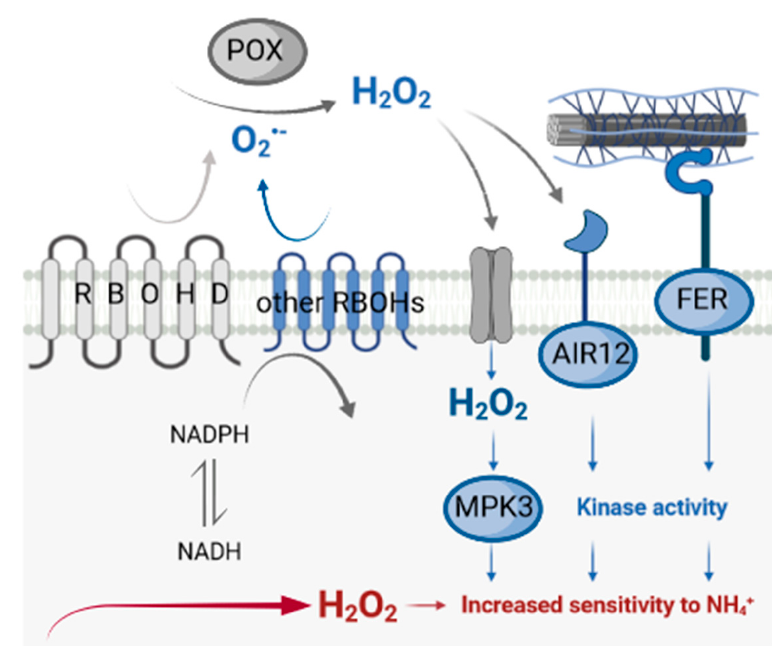
Figure 7. Metabolic effects of RBOHD disfunction for plants nourished with ammonium. When the major RBOHD is not active, other RBOHD isoforms cannot compensate for its activity, and O 2 − production is diminished. Lower O 2 − availability or POX activity can lead to decreased H 2 O 2 contents as their product. As a consequence, H 2 O 2 -responsive receptors such as AIR12 are downregulated. Another cell-wall receptor is FER, and decreased pectin methyl-esterification leads to lower expression. Further signaling pathways from these receptors are not activated in cells, such as in the MAPK cascade. Since the H 2 O 2 level is low in the apoplast, it would also pass to a minor extent into the cytosol; hence, direct activation of intracellular signaling kinases such as MPK3 is limited. Impaired apoplast/cytosol signaling does not induce defense/antioxidant systems, and therefore oxidative stress develops in cells. Due to these disturbances, rbohd showed high sensitivity to ammonium fertilization. Reduced responses are highlighted in blue, and red shows induced reactions. The scheme was created with BioRender.com.